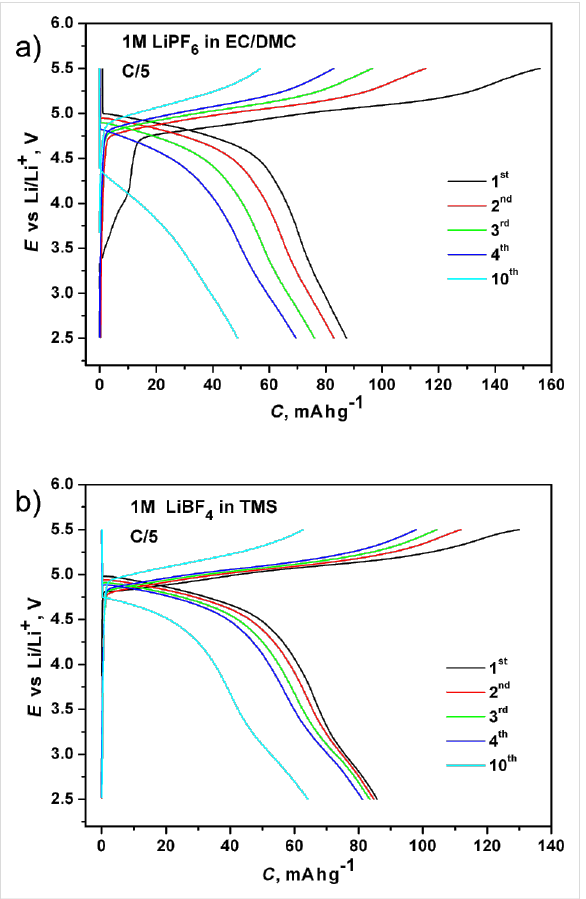
Figure 6: Charge-discharge curves of Li 2 CoPO 4 F in the commercial (a) and in the sulfone-based electrolytes (b) measured at C/5.